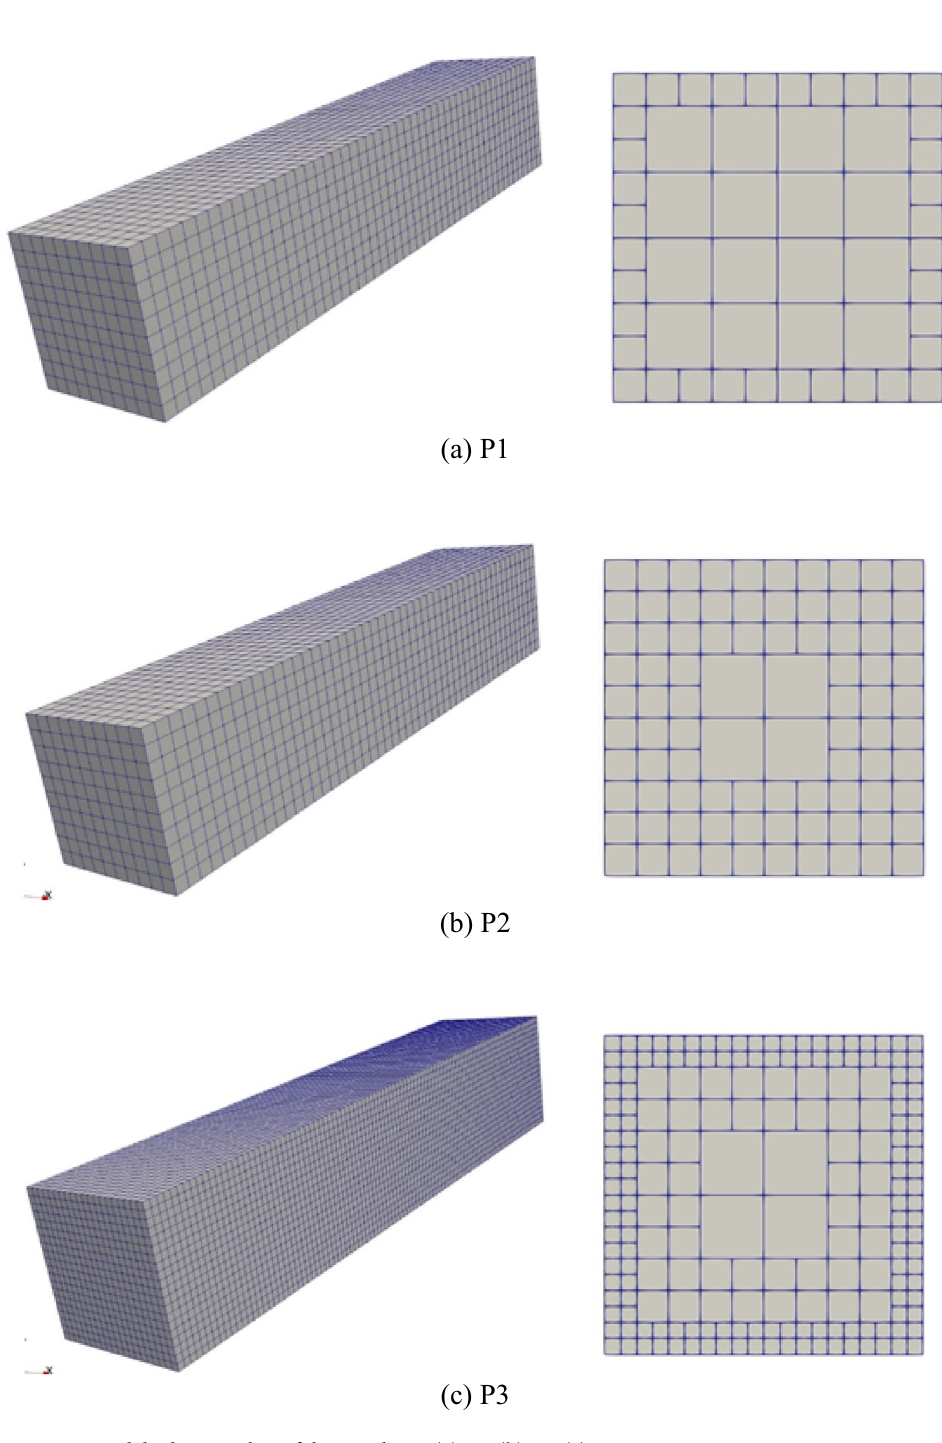
Figure 11. Polyhedron meshes of the cantilever. ( a ) P1, ( b ) P2, ( c )